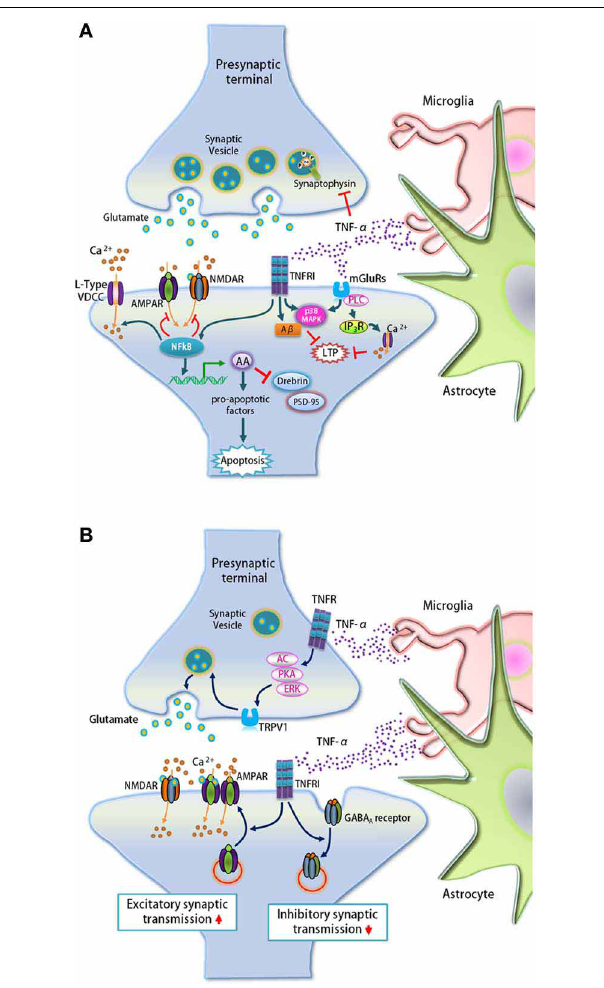
FIGURE 4 | TNF- α regulates synaptic loss, synaptic transmission, and plasticity. (A) TNF- α secreted by microglia and astrocytes up-regulates arachidonic acid (AA) via the NF- κ B pathway that leads to synaptic loss by activating pro-apoptotic factors. The elevated AA signaling also down-regulates the expression of post-synaptic proteins drebrin and PSD-95, and pre-synaptic protein synaptophysin. In addition, TNF- α regulates intracellular calcium levels through the NF- κ B pathway by regulating calcium entry through VDCCs, while suppressing glutamate receptor agonist-induced currents in hippocampal neurons. Lastly, TNF- α blocks the early phase of LTP through the activation of TNFR1 and mGluRs and this process is dependent on p38 MAPK, IP 3 receptor-mediated calcium release via PLC and A β . (B) Glia-derived TNF- α signals through pre- and post-synaptic TNFR1 to regulate pre-synaptic neurotransmitter release and the surface expression of AMPARs and GABA A receptors, respectively. In spinal cord outer lamina II neurons, TNF- α increases spontaneous EPSC frequency via TRPV1-mediated glutamate release that is mediated by AC, PKA, and ERK pathways from pre-synaptic terminals. At the post-synapse, TNF- α promotes GluA2-lacking AMPAR trafficking to the surface and induces GABA A receptor